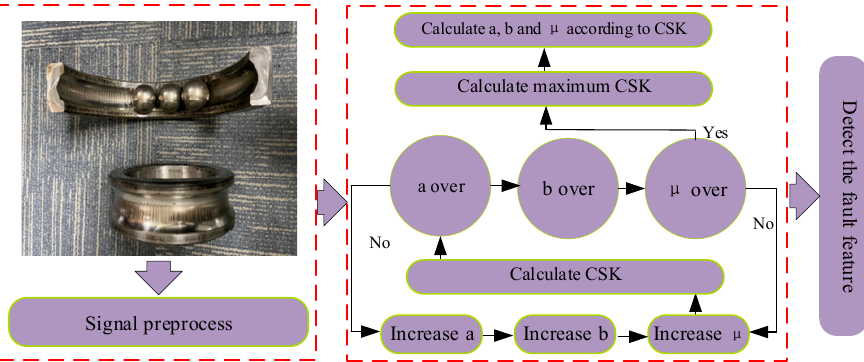
Figure 4. Proposed CSK-based APHSR method for bearing fault feature of wind power generator.